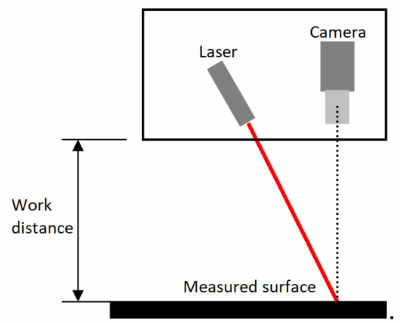
Figure 1. Measurement scheme using laser